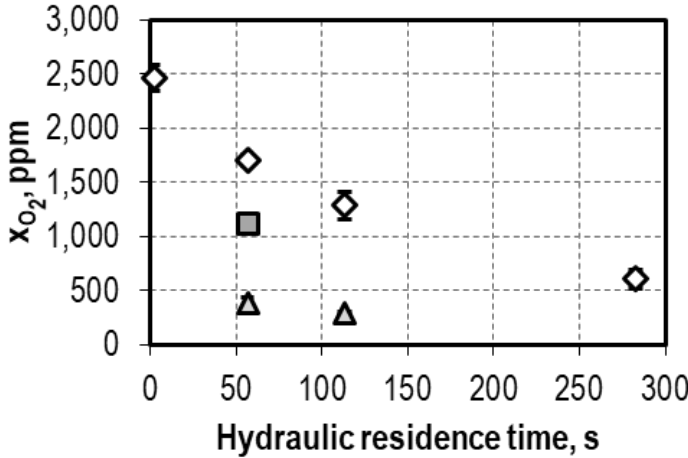
Figure 1. Oxygen reduction from a biogenic syngas from entrained flow gasification of biogenic residues (torrefied wood, TorrCoal) by a plug flow reactor (inner diameter 10 mm; length 1000 mm) filled with 30 g Pd-catalyst particles and 10 g silica beads at temperatures of 25 °C (white diamonds), 40 °C (dark grey square), and 50 °C (light grey triangle) as a function of the mean hydraulic residence time in the plug flow reactor. p CO = 300 mbar, p H2 = 220 mbar, p CO2 = 90 mbar, p N2 = 390 mbar. Error bars indicate the standard deviation of a minimum of 10 measurements per data point.